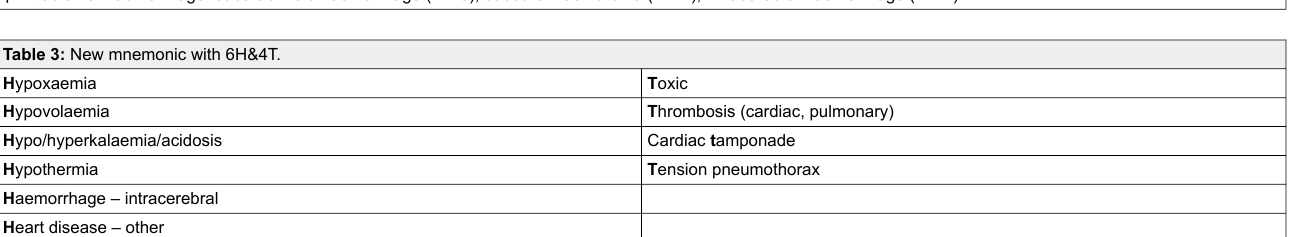
Table 3: New mnemonic with 6H&4T. H ypoxaemia T